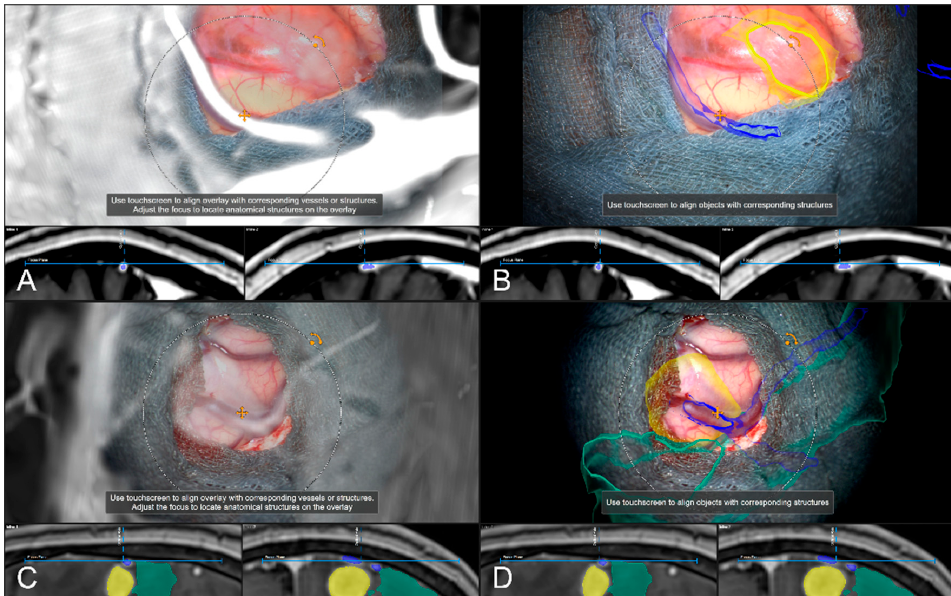
Figure 8. High spatial navigation accuracy seen in the recent focus plane utilizing a MIP of a preoperative T1-CE image ( A , C ), and patient anatomy enhanced with segmented vascular structures (blue), tumor outlines (yellow) and precentral gyrus (green) ( B , D ) in two patient cases, showing the different quality of preoperative imaging data (In parallel view of MIP projection and patient anat- omy (upper part) and inline views with the recent focus plane (blue line) and the optical axis (dashed blue line) in the bottom part).